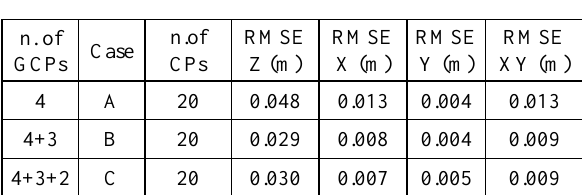
Table 5. RMSE in FreeNet Solution Type